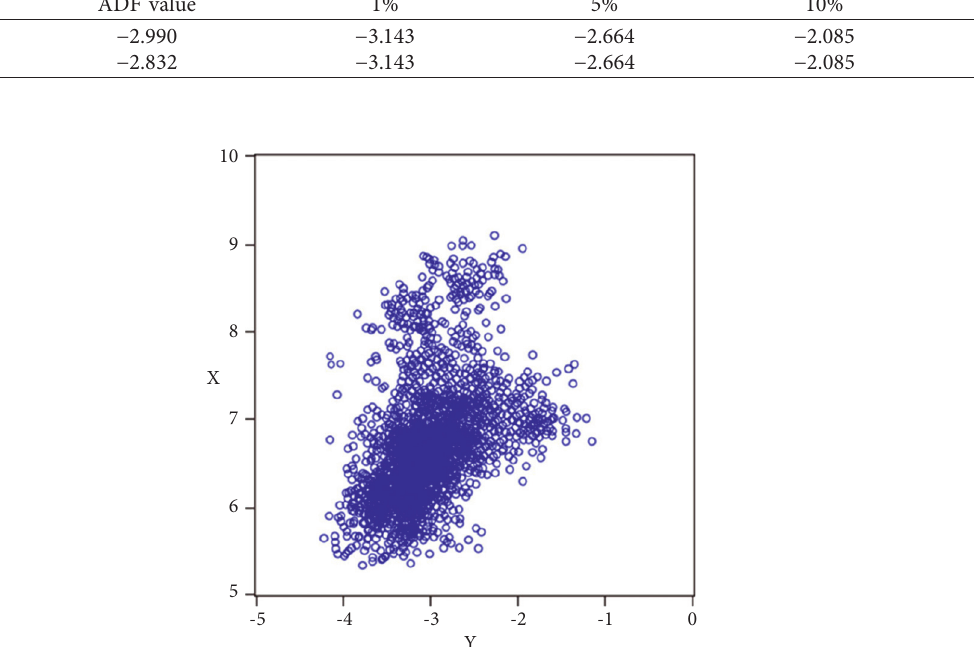
Figure 3: Relationship between ln (RCSDI) and ln